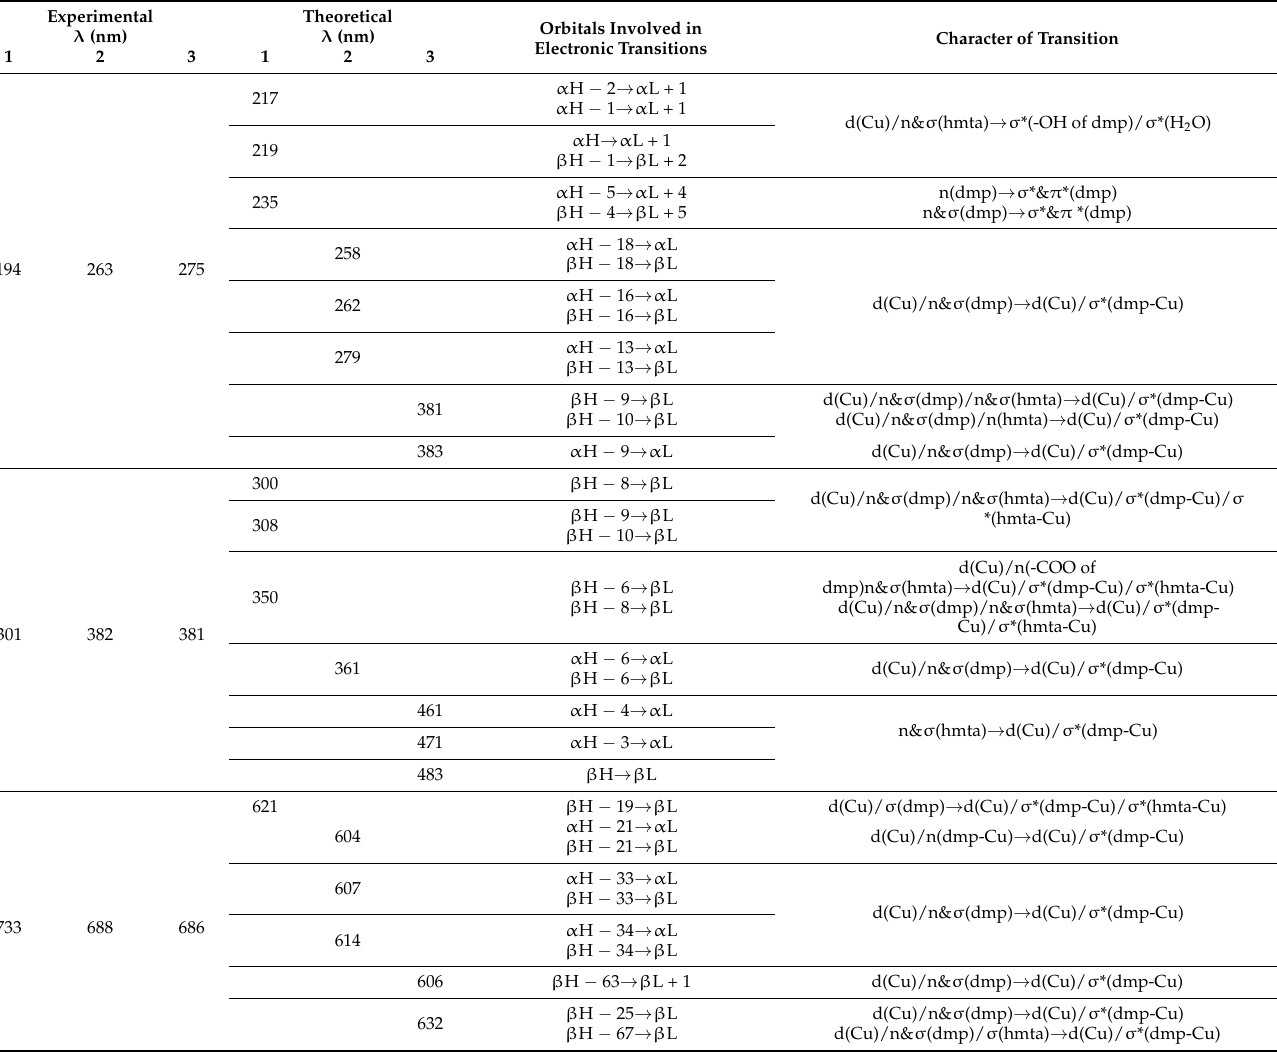
Table 4. The most important electronic transitions. H letter indicates HOMO, L—LUMO, α — α orbitals, β — β orbitals, and +/ − (number) represents subsequent orbitals above HOMO and LUMO,